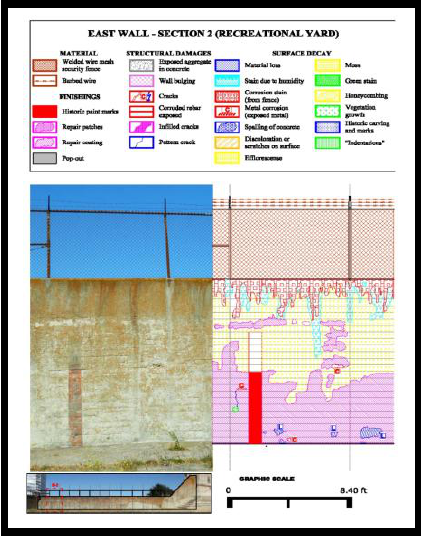
Figure 13. Wall Damage Map